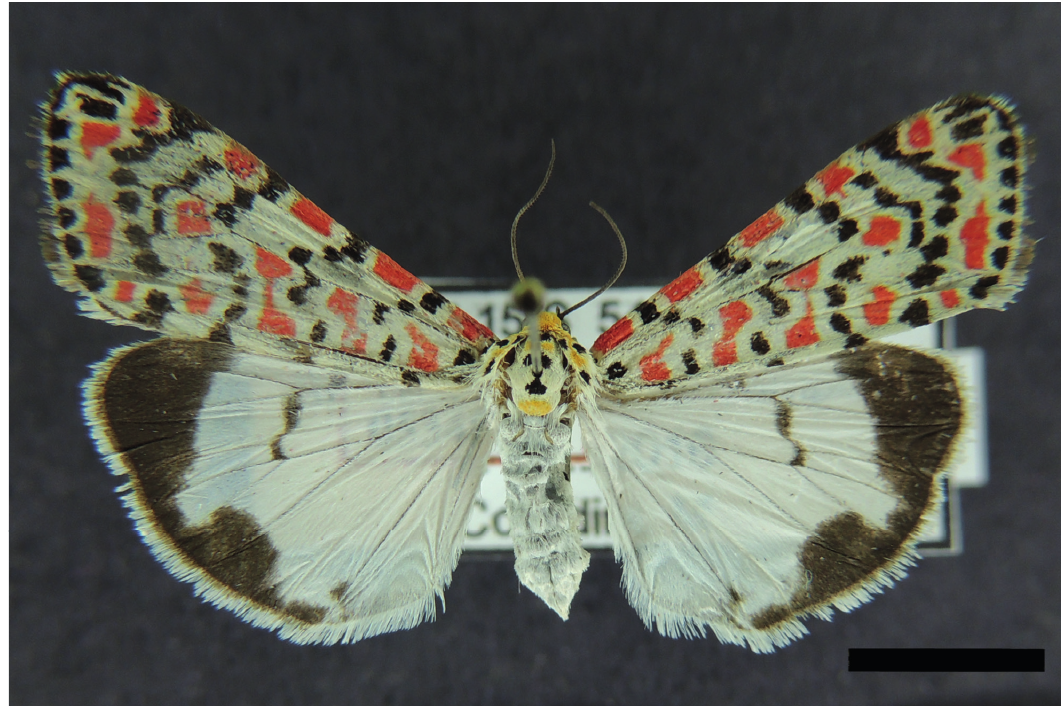
Figure 1 - Utetheisa pulchella (linnaeus, 1758), dorsal view, male. Scale bar = 1cm.